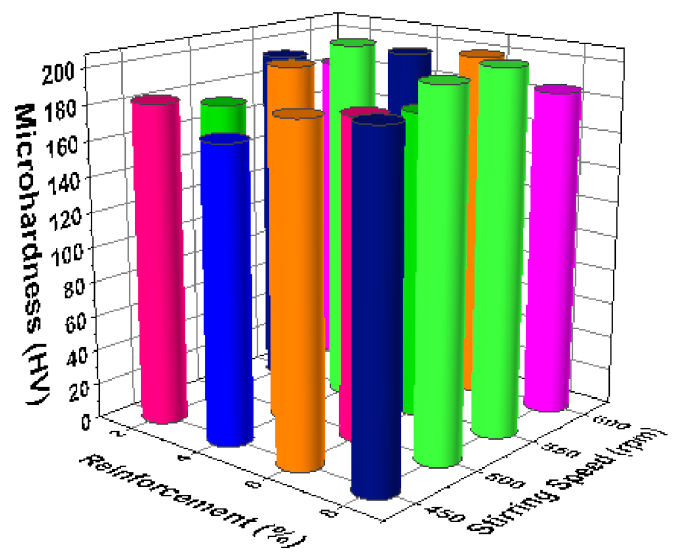
Figure 17. 3D bar plot: reinforcement vs. stirring